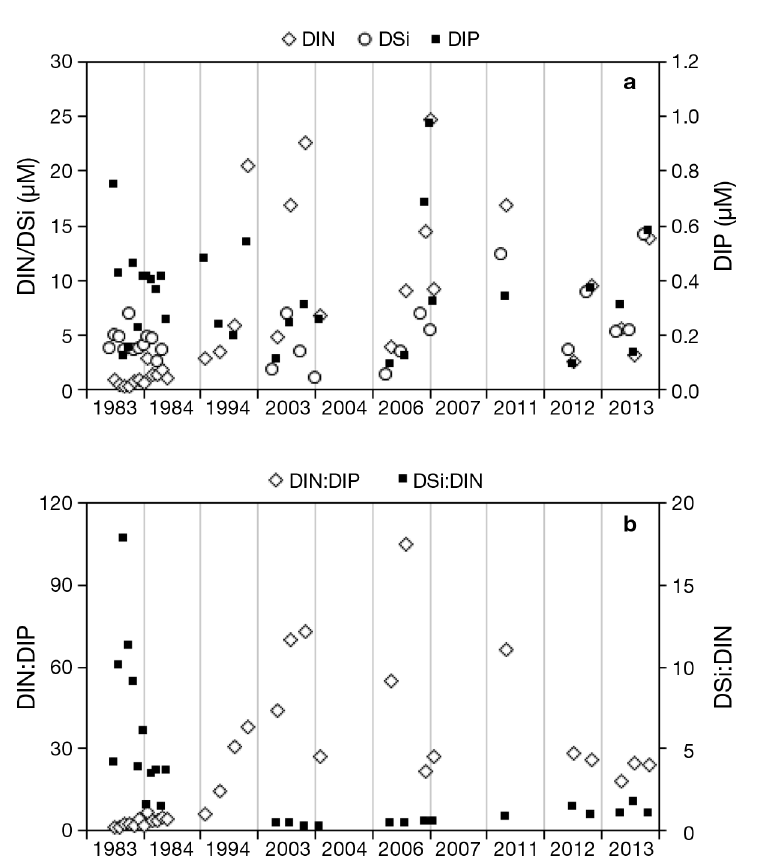
Fig. 9. Long-term changes in (a) the concentrations of dissolved inor- ganic nitrogen (DIN), dissolved inorganic phosphorus (DIP), and dis- solved silicate (DSi) concentrations, and (b) the DIN:PO 43− and DSi:DIN ratios for the period 1983 to